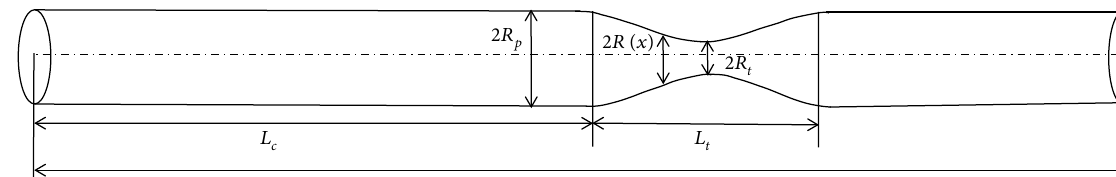
fl ooding (1: CO region, 2: miscible region, and 3: oil region). 2 2